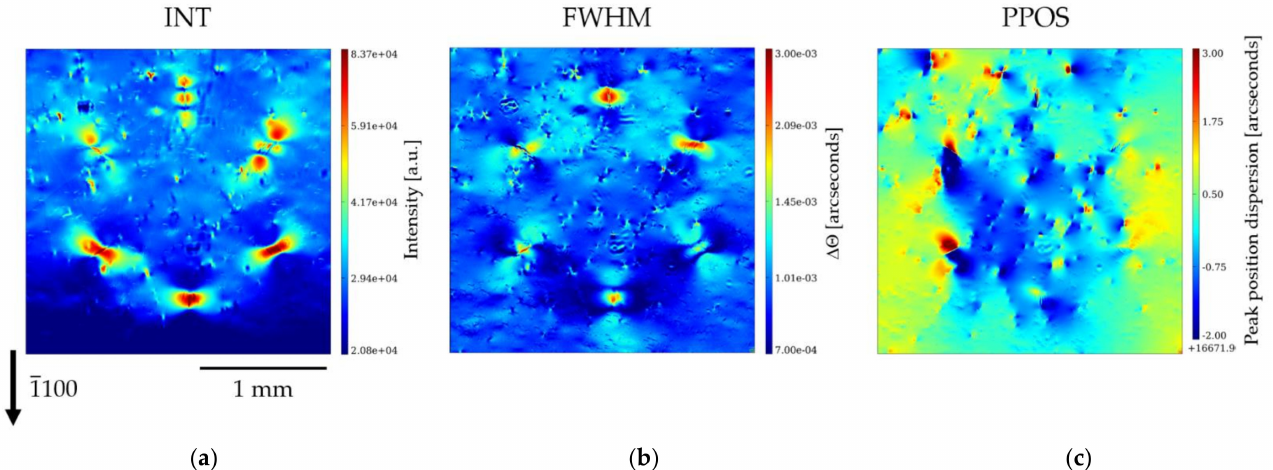
Figure 12. RCI maps of the 1100 reflection at 30 keV: ( a ) integrated intensity map (INT); ( b ) full-width at half-maximum map (FWHM); ( c ) peak position map